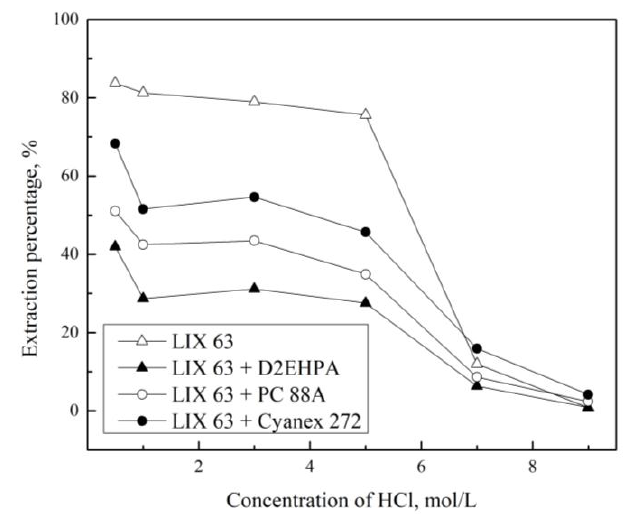
Figure 3. Effect of HCl concentration on extraction of Pd(II). Aqueous: [Pd] = 100 mg/L, [HCl] = 0.5–9 mol/L. Organic: 0.01 mol/L 5,8-diethyl-7-hydroxyldodecane-6-oxime (LIX 63), 0.01 mol/L LIX 63 + 0.1 mol/L Cyanex 272/PC 88A/D2EHPA. O/A = 1. Diluent: kerosene.